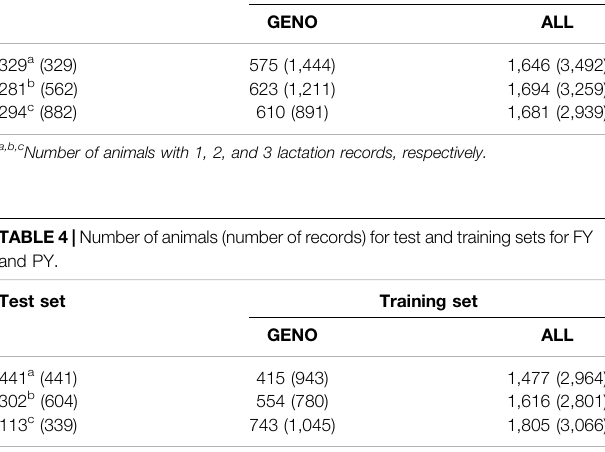
TABLE3| Numberofanimals(numberofrecords)fortestandtrainingsetsforMY. Test set